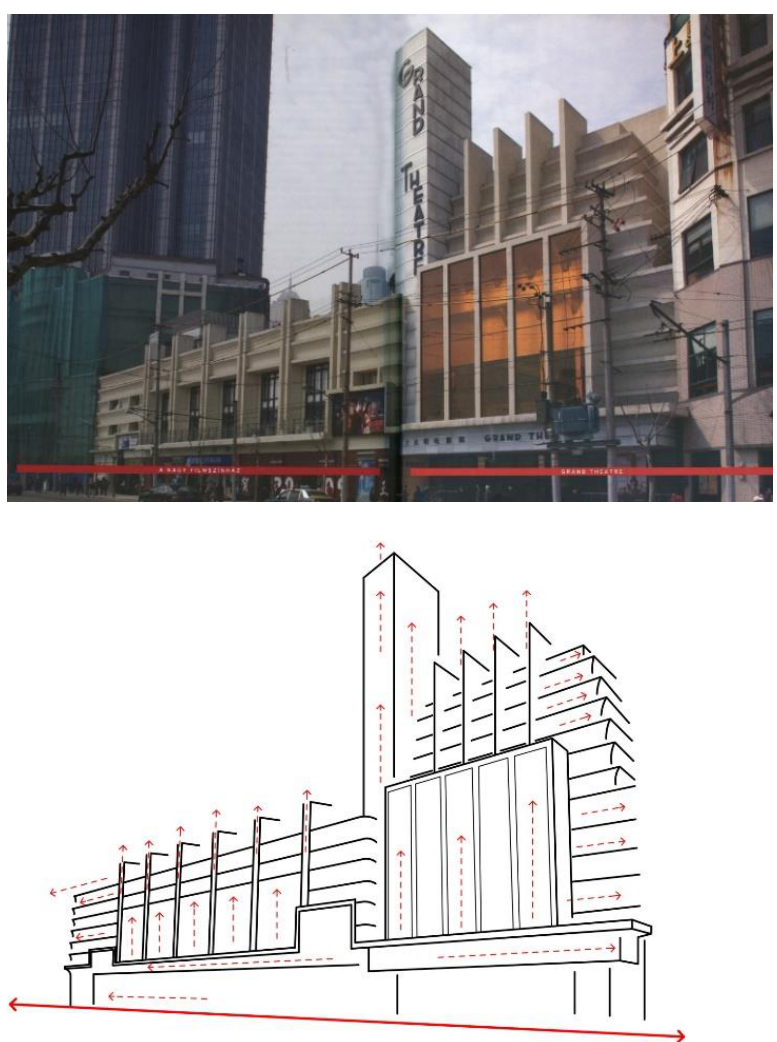
Figure 19. Grand Theatre — ( top ) main view from the former race course, ( bottom ) compositional study of the façade ’s grammar , Art Deco and International Style.